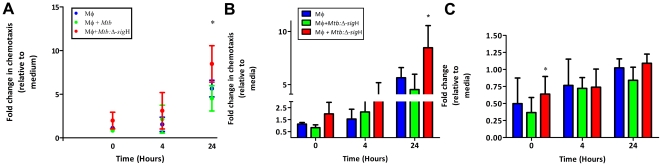
Chemotaxis assay.Migration of PBMCs (A) in response to supernatants from uninfected macrophages (black), macrophages infected with Mtb (green), Mtb:Δ-sigH (red) relative to tissue culture medium. Values are expressed as cells/microscopic field. Similarly, values are also shown for CD14+ (B) and CD3+ (C) population in the PBMCs.